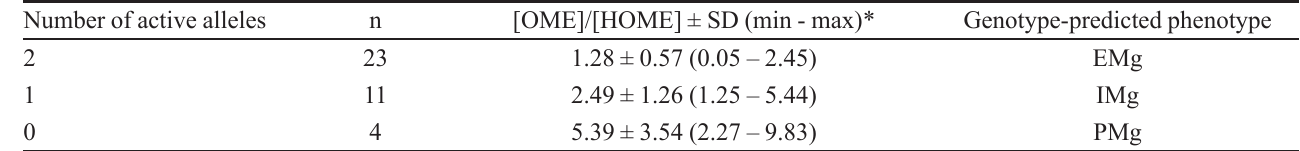
* statistically significant difference among groups, P = 0.001, Kruskal-Wallis